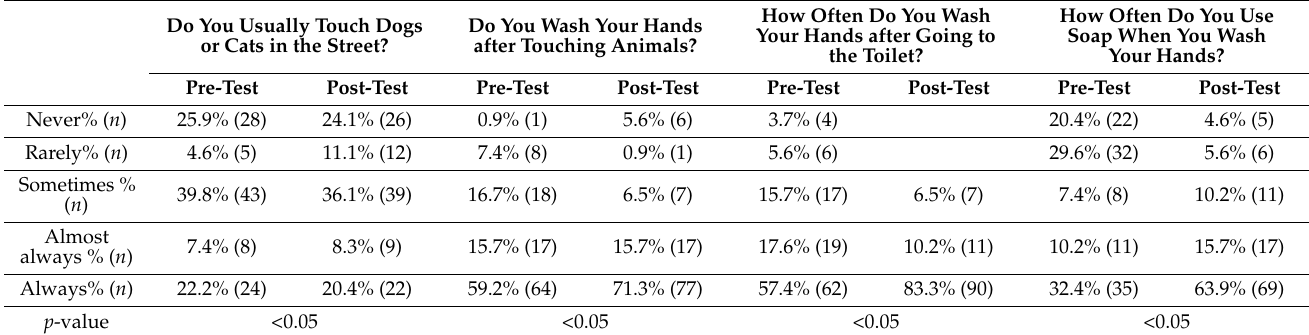
Table 4. Handwashing hygiene habits comparing the impact of the educational intervention when comparing pre-test and